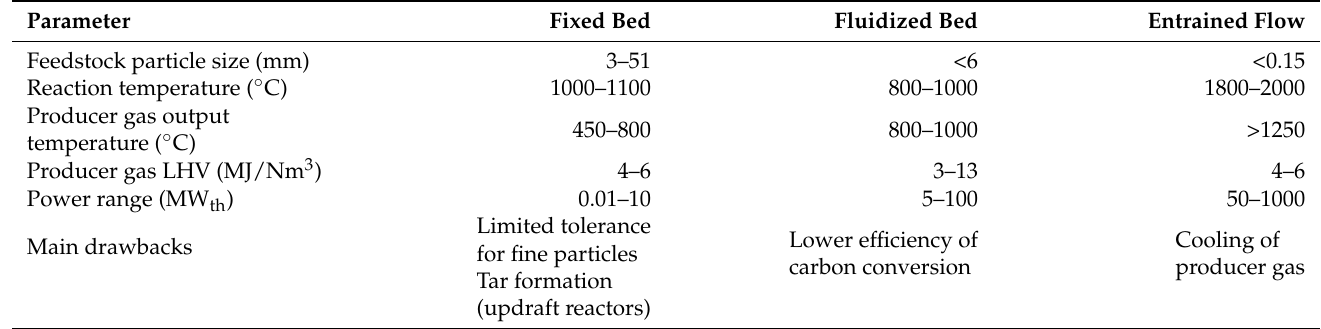
Table 2. Operating parameters for different types of